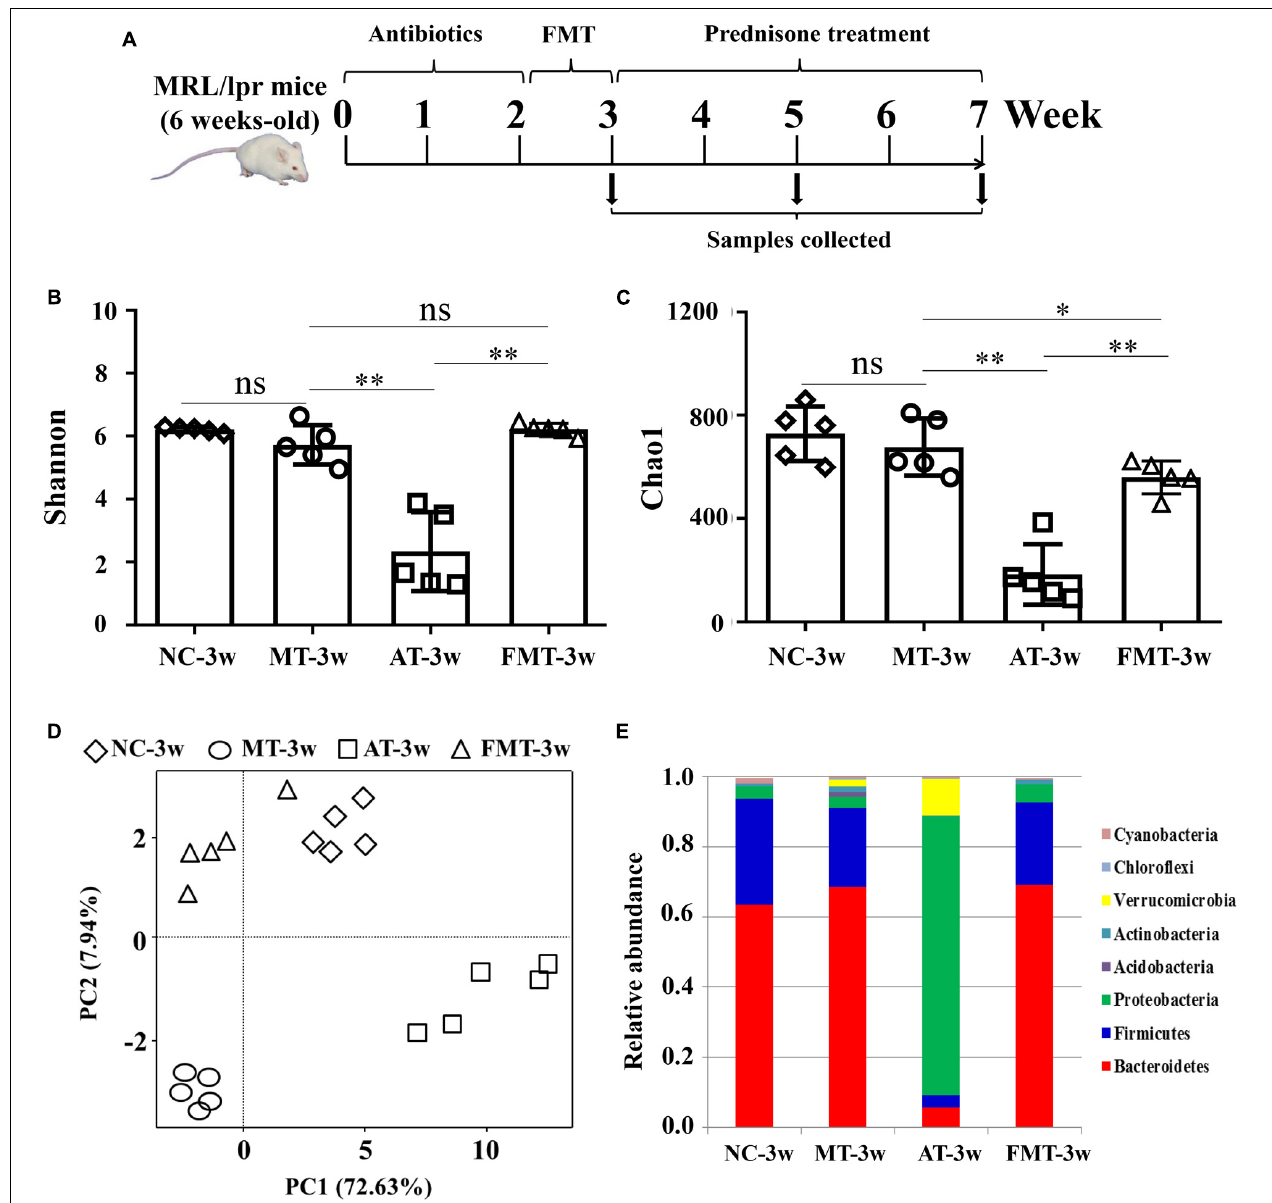
FIGURE 1 | Alterations in gut microbiota caused by antibiotics or fecal microbiota transplantation. (A) A diagram of the experimental treatments is shown. (B) The Shannon index of the gut microbiota is shown. (C) The Chao1 index of the gut microbiota is shown. (D) Alterations in the overall community structures are shown in the PCoA plot. (E) The percent abundance of the identified major phylum is shown. NC, The C57/BL6 mice treated with PBS solution from 6 to 9 weeks old; MT, the MRL/lpr mice treated with PBS solution from 6 to 9 weeks old; AT, the MRL/lpr mice treated with antibiotics from 6 to 8 weeks old and PBS solution from 8 to 9 weeks old; FMT, the MRL/lpr mice treated with antibiotics from 6 to 8 weeks old and fecal microbiota transplantation from 8 to 9 weeks old. “ ∗∗ ” represents p < 0.01; “ ∗ ” represents p < 0.05; “ns” represents no significant difference. N = 5/group.